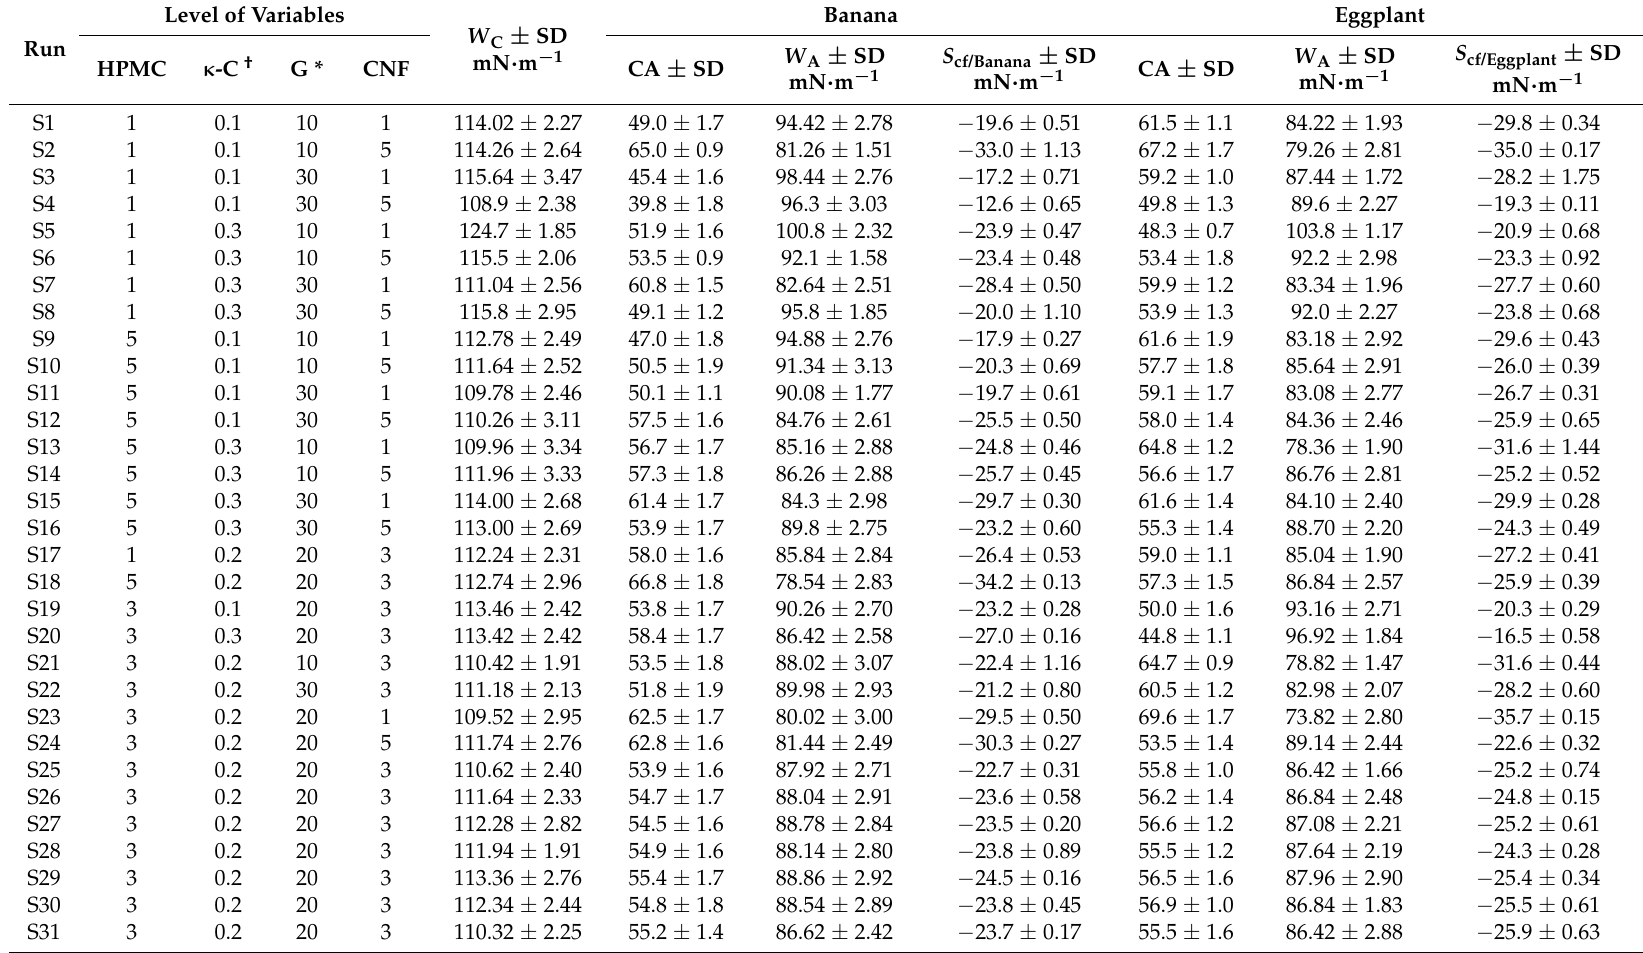
Table 1. Design matrix in the Box-Behnken model and response values obtained from experimental